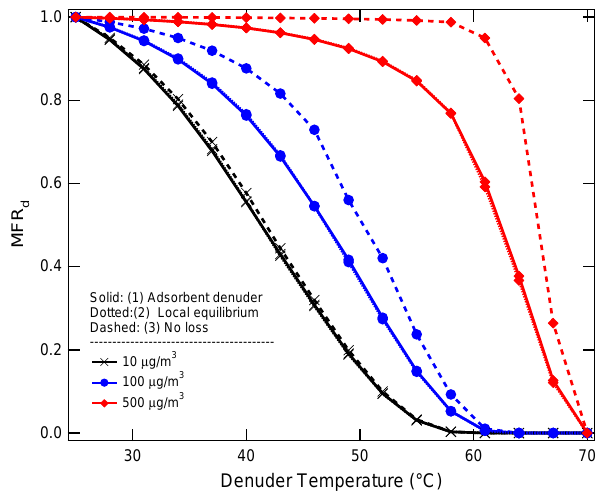
Fig. 5. The mass fraction remaining (MFR d ) is shown for the three different wall boundary conditions considered, i.e. the adsor- bent denuder (Case 1, solid lines), local equilibrium (Case 2, dotted lines) and no loss (Case 3, dashed lines) for various C OA assuming C sat =10µg/m 3 , 1H vap =90kJ/mol, t res =16s, d p =200nm and γ e =1 to illustrate the influence of recondensation. The results from Case 1 and Case 2 are indistinguishable. The C OA used were 10µg/m 3 ( × ) , 100µg/m 3 ( • ) and 500µg/m 3 ( (cid:7) ) . Note that MFR d is used here, i.e. the mass fraction remaining relative to the aerosol after having passed through the thermodenuder at T ref